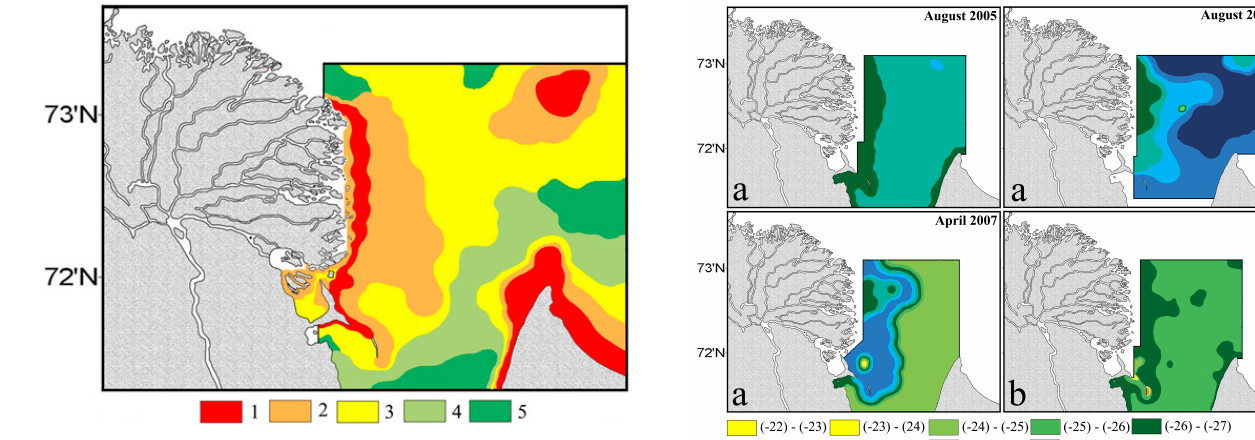
Fig. 8. Types of bottom sediments: 1 – sand, 2 – silty sand, 3 – clayey silt, 4 – silty clay, 5 – clay.